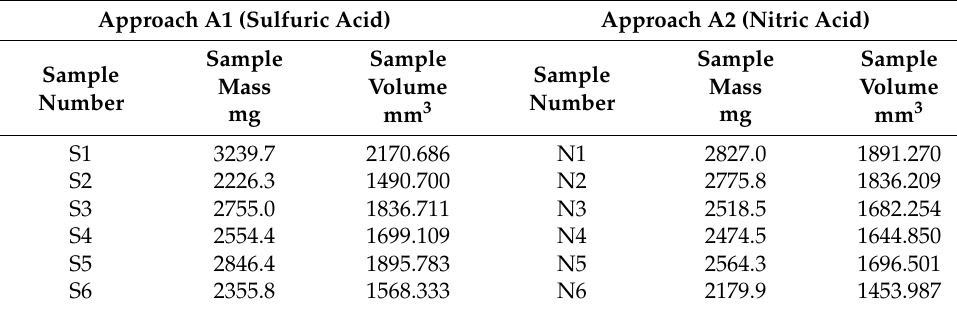
Table 1. Mass and volume of the 12 destructive tested samples.